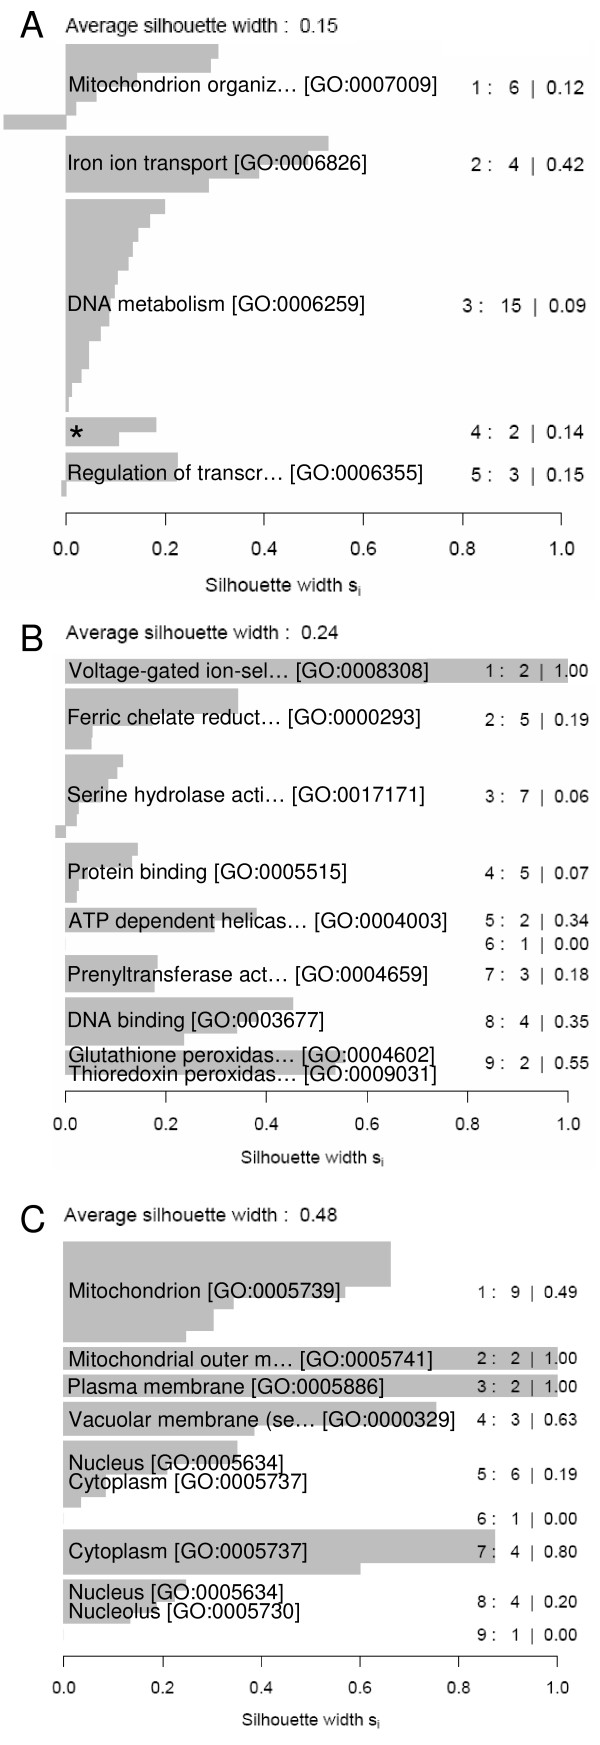
Silhouette plots of PAM clustering results for Schreiber data set. Silhouette plots of PAM clustering results for 37 rapamycin-inhibitor binding proteins for GO (A) BP, (B) MF and (C) CC. Proteins assigned either the unknown term from each GO aspect (GO:0000004 biological process unknown, GO:0005554 molecular function unknown and GO:0008372 cellular component unknown) or using the evidence code Inferred from Electronic Annotation were not included in the clustering. Therefore 30 proteins were clustered in BP, 31 in MF and 32 in CC. The silhouette width for the entire set (average silhouette width, siD) is found at the top of each figure whereas the silhouette width for each cluster (siC) is found on the right-hand side of the figure with the cluster number (left of the colon) and number of proteins in each cluster (right of the colon). Each cluster is labelled with the GO annotation of the medoid, except BP cluster 4 as the text did not fit on the figure. Each protein is represented by a bar and the width of the each bar represents the silhouette width for each protein (si). * GO annotation for BP cluster 4 is GO:0046856 phosphoinositide dephosphorylation, GO:0048017 inositol lipid-mediated signaling and GO:0030476 spore wall assembly (sensu Fungi).